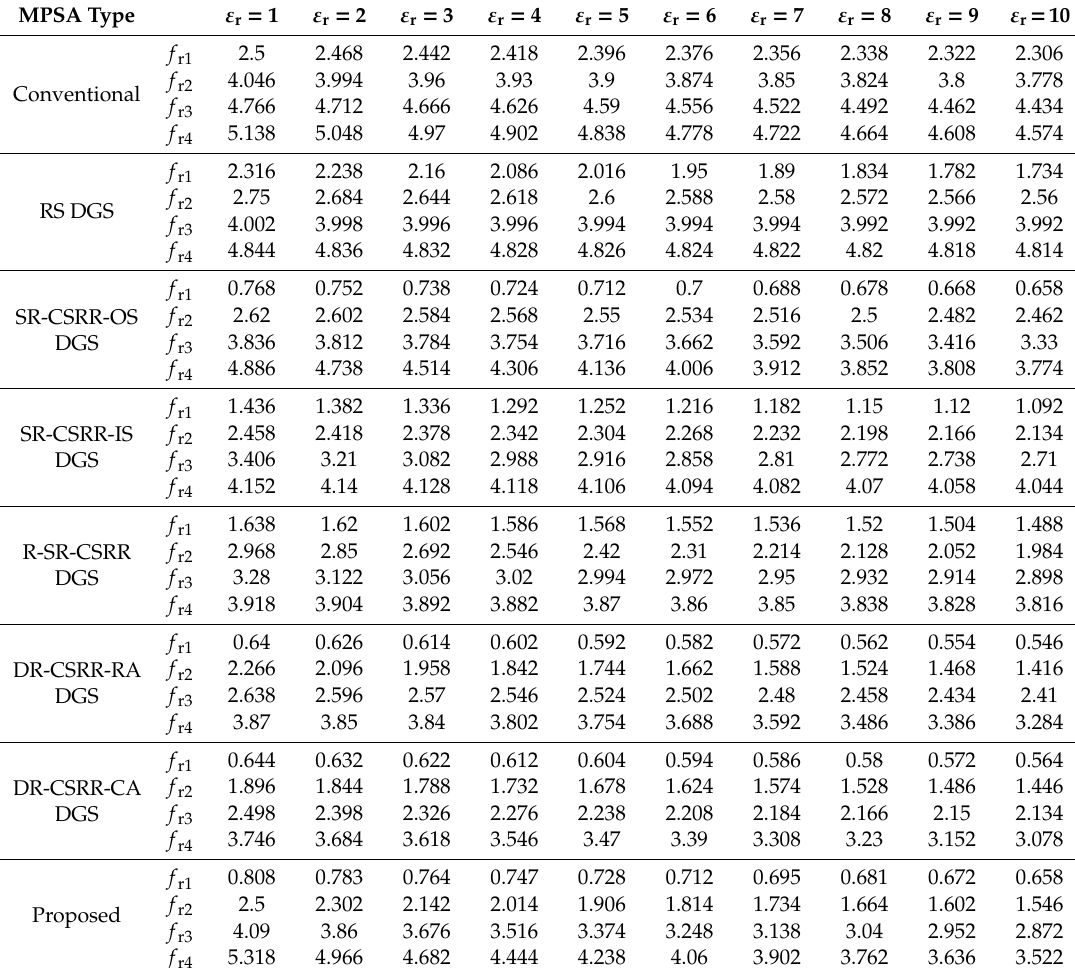
Table 1. The first four resonant frequencies of the S 11 responses from the eight MPSAs (in gigahertz). MPSA Type